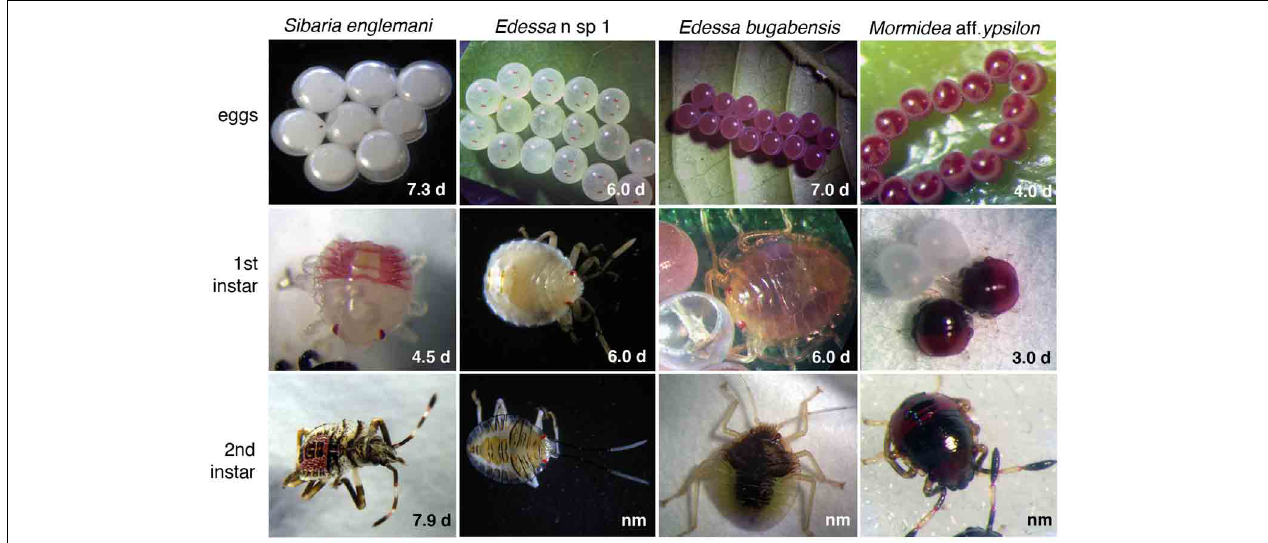
FIGURE 6 | Developmental series for four species used in this study. Developmental duration for each life stage is noted. Average egg diameter, 1st instar length, and 2nd instar length was as follows: Sibaria englemani = 1.0, 1.3, 2.0mm; Edessa n sp. 1 = 2.5, 3.0, 4.1mm; Edessa bugabensis =